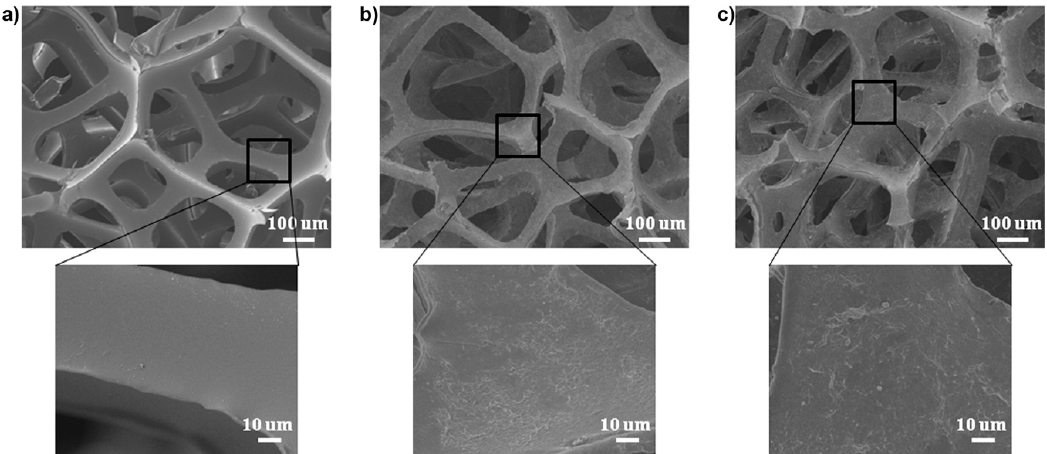
Figure 24. Schematic representation of Layer-by-Layer (LbL) assembly with chitosan (CH) and sodium montmorillonite clay (MMT). This process is repeated until the desired number of bilayers is deposited. Reprinted with permission from [53]. Copyright 2012, American Chemical Society.